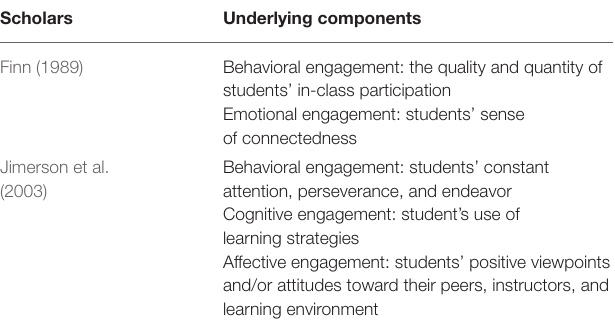
TABLE 1 | Different categorizations of student